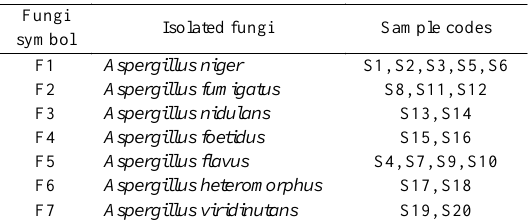
Table 3: The isolated fungi species from contaminated soil samples